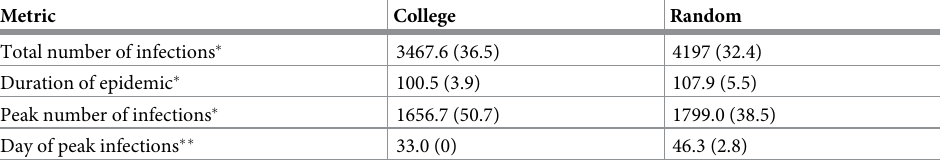
Table 3. Comparison of unmitigated spread on the college vs random networks. The four main response variables are presented as means ( ± 95% CI). No masking or testing was done. All eight samples were normally distributed. All responses were significantly different between the college and random networks using a t-test (df = 18). Note that the outbreaks were completed after approximately one semester (105 days) and infected an average of 63% and 76% of the college and random network individuals, respectively.